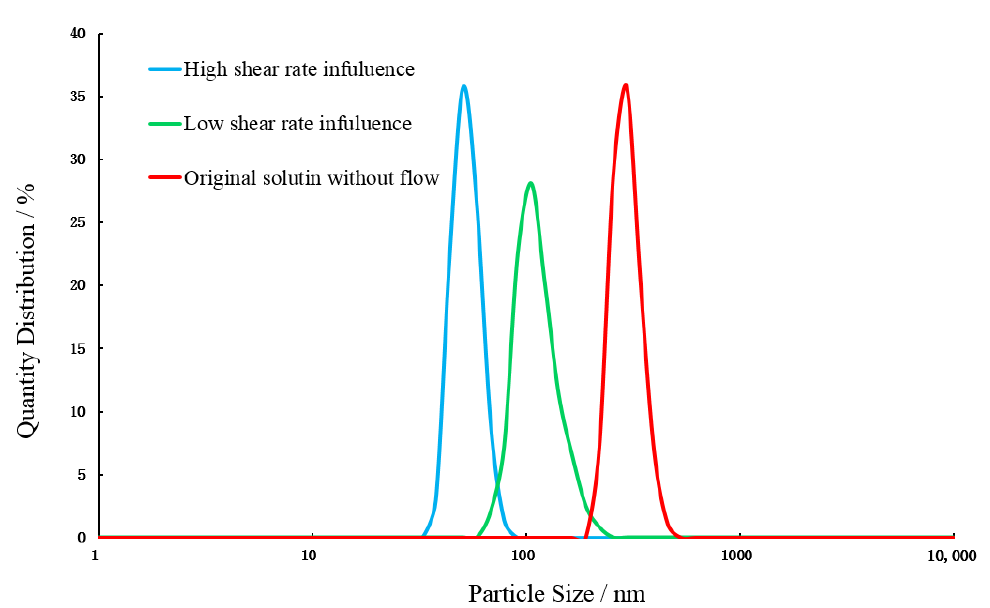
Figure 7. Distributions of grain sizes of the drag reducer solutions subjected to shears of different rates.